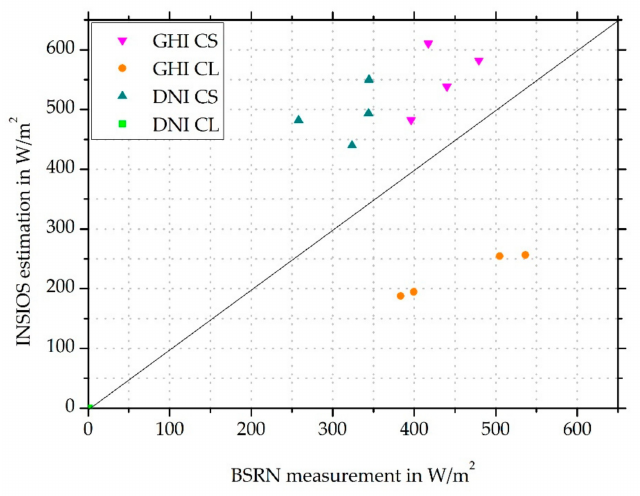
Figure 5. Mean GHI and DNI estimated from INSIOS technique as compared to BSRN data for clear and cloudy conditions for all